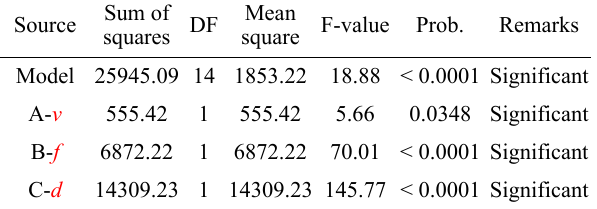
Table 4 ANOVA table of tool wear (VB) for Alumina nanofluid. Mean Sum of Source DF F-value Prob. square squares